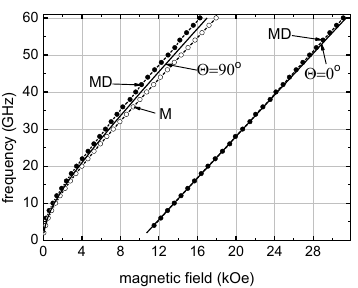
Fig. 3. FMR frequencies for a material with anisotropy of the EMP type, Н a1 = – 10 kOe, H a2 = H = H =0 kOe, α = 0.1, γ/2π = 2.8 GHz / a3 Φ